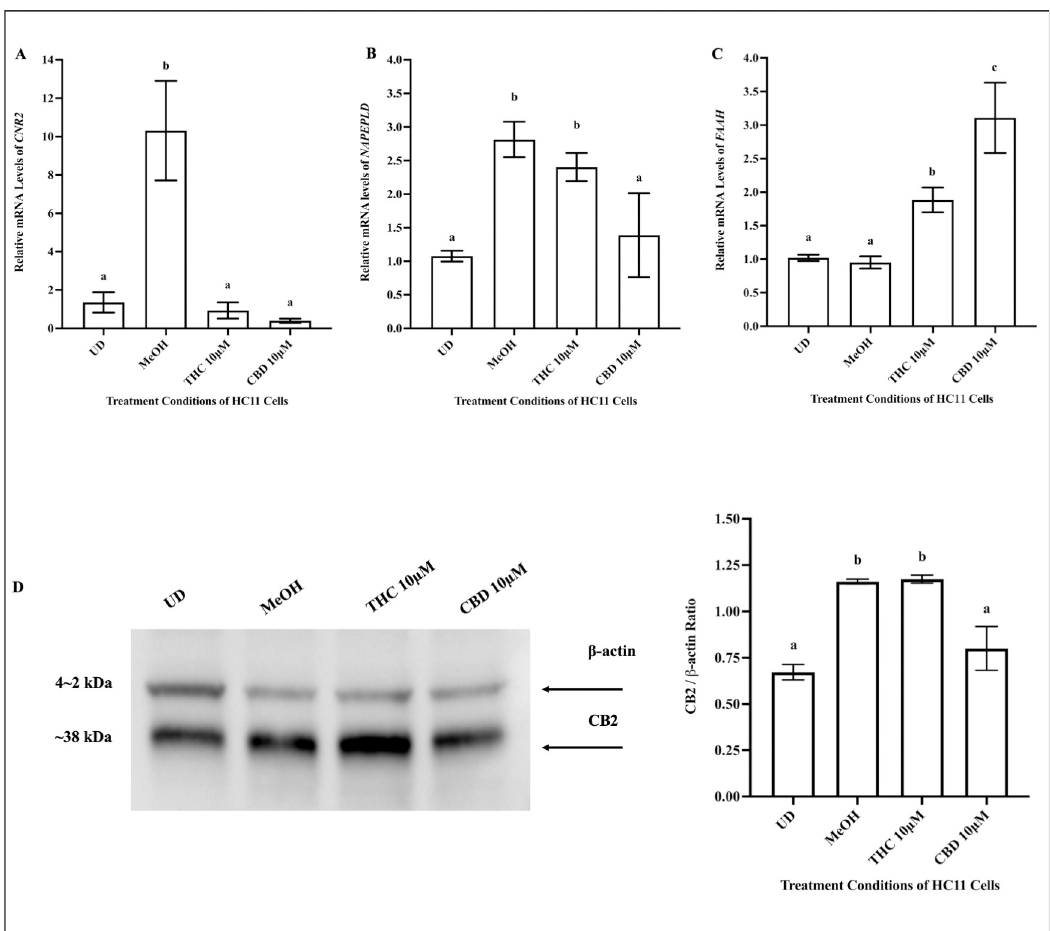
Fig 6. 10 μ M THC and 10 μ M CBD altered mRNA levels of ECS markers in HC11 cells. HC11 cells were seeded in base media for 24 hours (UD) and processed for total RNA or protein isolation, as described in the methods. HC11 cells were differentiated in base media containing PRL, INS and DEX, and treated with vehicle control (MeOH), 10 μ M THC or 10 μ M CBD for 4 days. Treated cells were processed for total RNA or protein isolation, as described in methods. The relative mRNA levels of CNR2 (A), NAPEPLD (B) and FAAH (C) were determined. Gene expression analysis was repeated with 6 distinct replicates. Milk protein expression was assessed, as described in methods, using 15 μ g of total protein for each sample. (D) A representative blot of CB2 expression is shown along with a bar graph quantifying its expression, normalized to β -actin, for undifferentiated (UD), and differentiated cells in the presence of vehicle (MeOH), 10 μ M THC, or 10 μ M CBD, based on 4 replicates. Results were plotted as mean ± SEM and compared using one-way ANOVA. Statistically significant changes were represented by distinct letters on bar